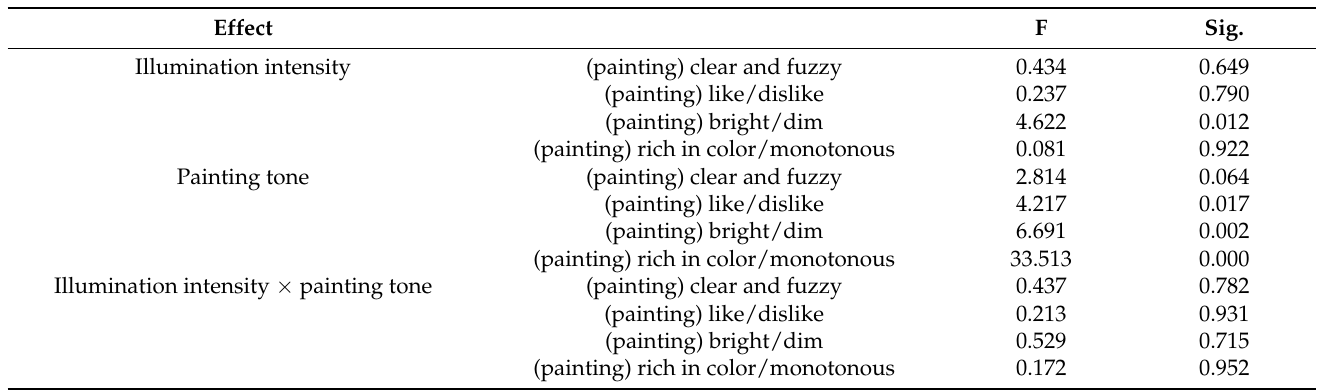
Table 8. Test of between-subject